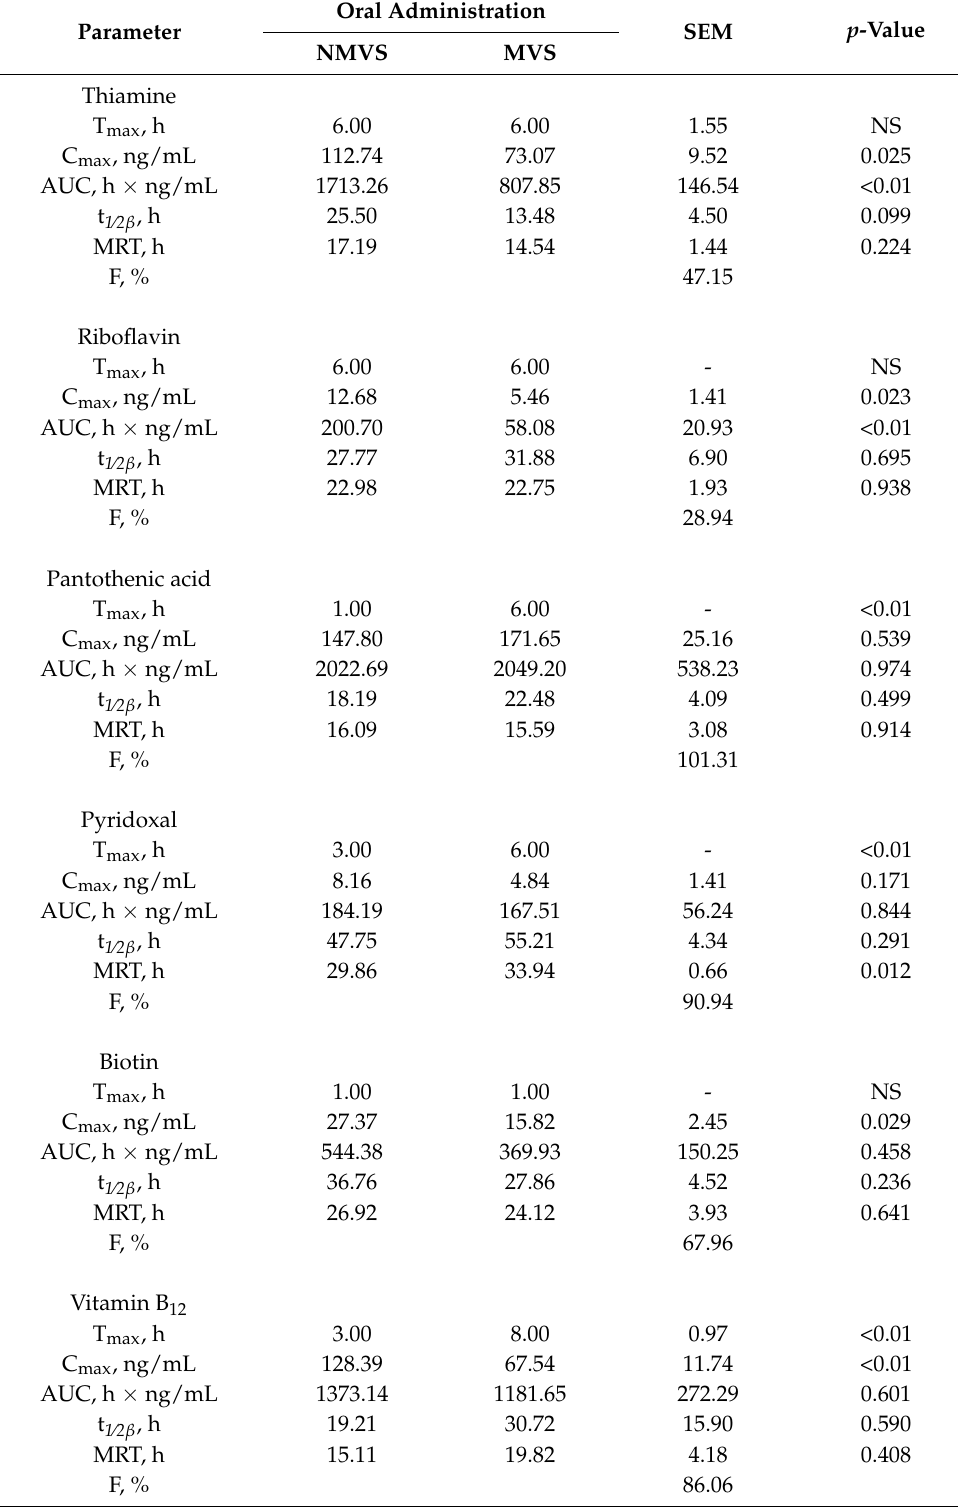
Table 3. Pharmacokinetic parameters of plasma water-soluble vitamin concentrations in pigs 1